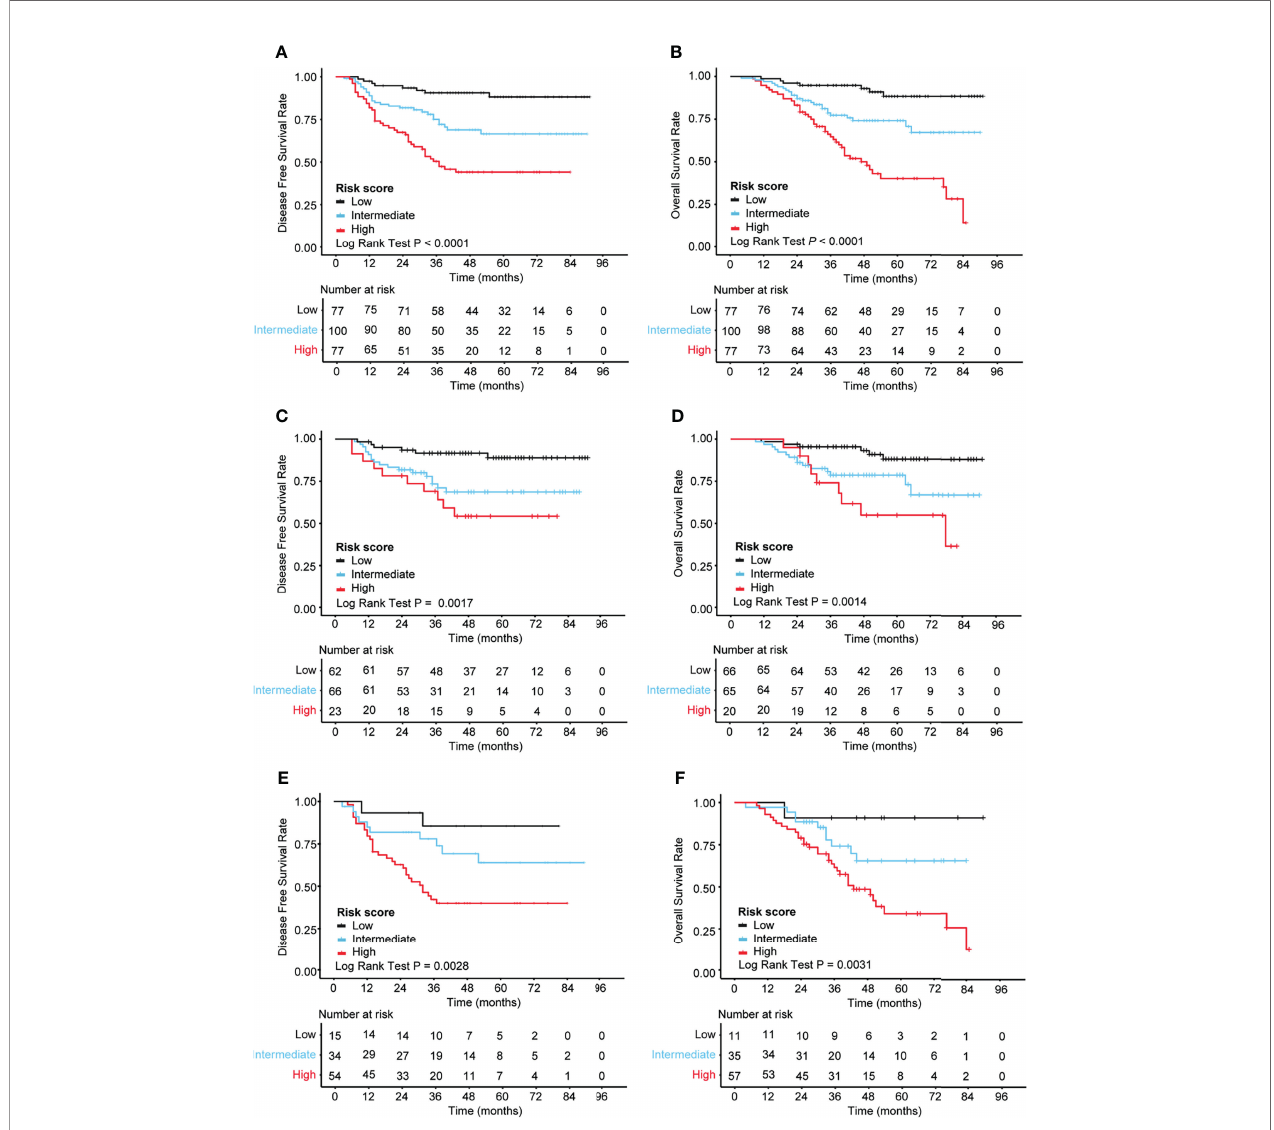
FIGURE 5 | Kaplan – Meier analysis of the different risk groups in 254 patients with stage II – III colorectal cancer (CRC). (A, B) K-M curves for DFS (A) and OS (B) in all patients ( n = 254). (C, D) K-M curves for DFS (C) and OS (D) in patients with stage II CRC ( n = 151). (E, F) K-M curves for DFS (E) and OS (F) in patients with stage III CRC ( n = 103). The log-rank test was performed to determine statistical differences. K-M, Kaplan – Meier; OS, overall survival; DFS, disease-free